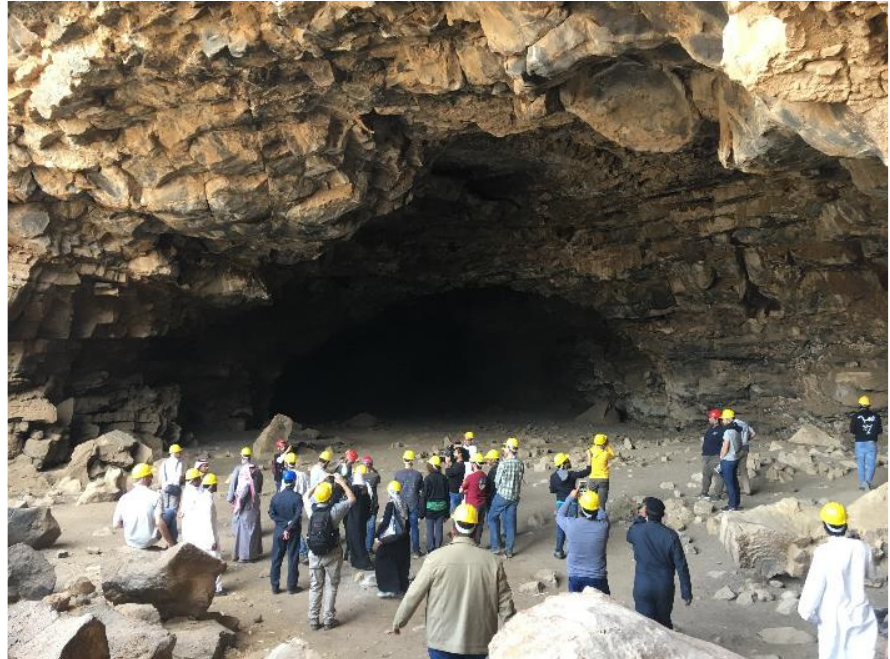
Figure 15. Umm Jirsan (25°35 18 N 39°45 25 E), which is Saudi Arabia’s longest lava cave. It is about 1500 m long and 45 m wide, with a maximum height of 12 m, and forms a major tourism a tt raction site and a globally signi fi cant geosite.